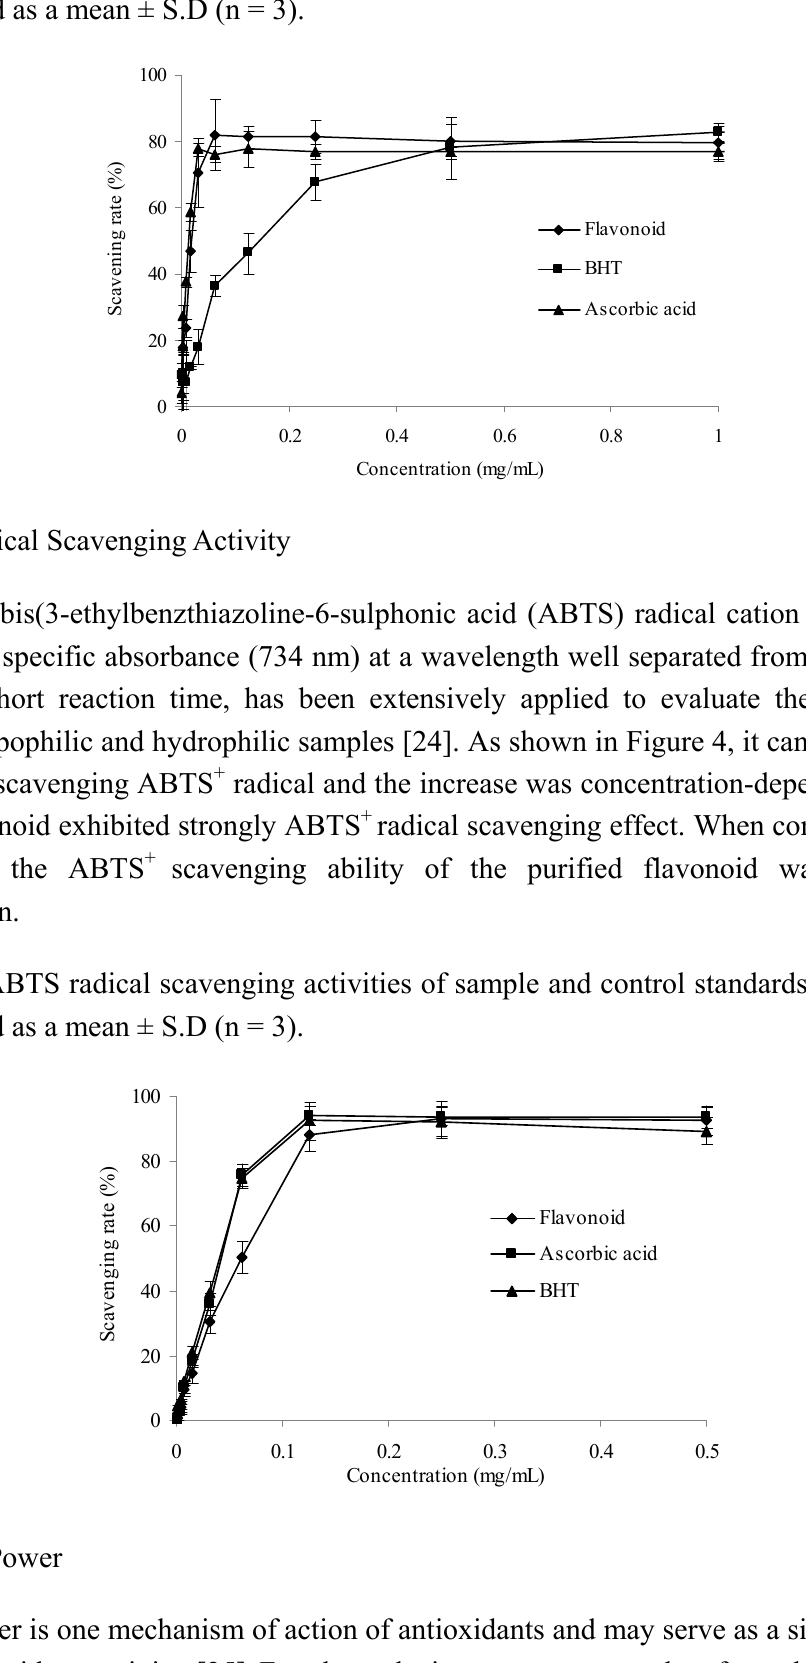
Figure 3. DPPH radical scavenging activities of sample and control standards. Each value is expressed as a mean ± S.D (n = 3).